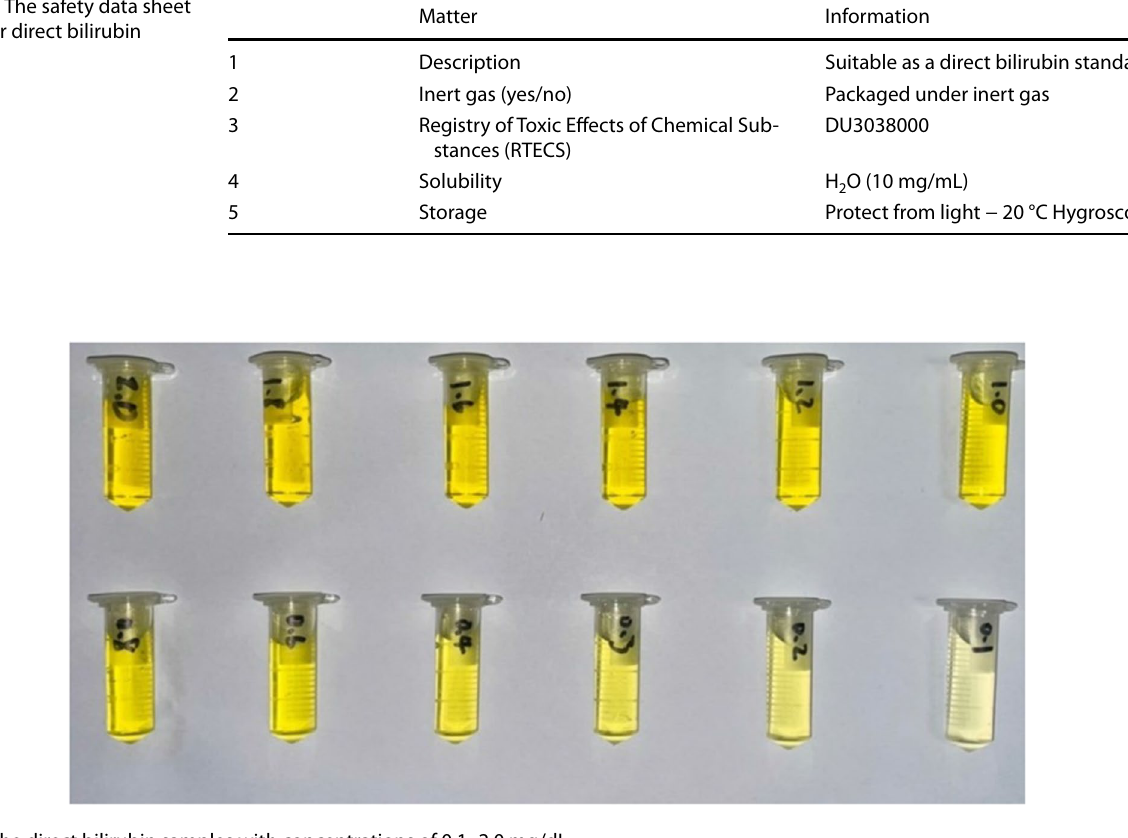
Fig. 1 The direct bilirubin samples with concentrations of 0.1–2.0 Fouchet’s Reagent (S-Y Fouchet Reagent-SY8076-1-11011019-Shih-Yung Instruments Co., Ltd) was used as an oxidase.